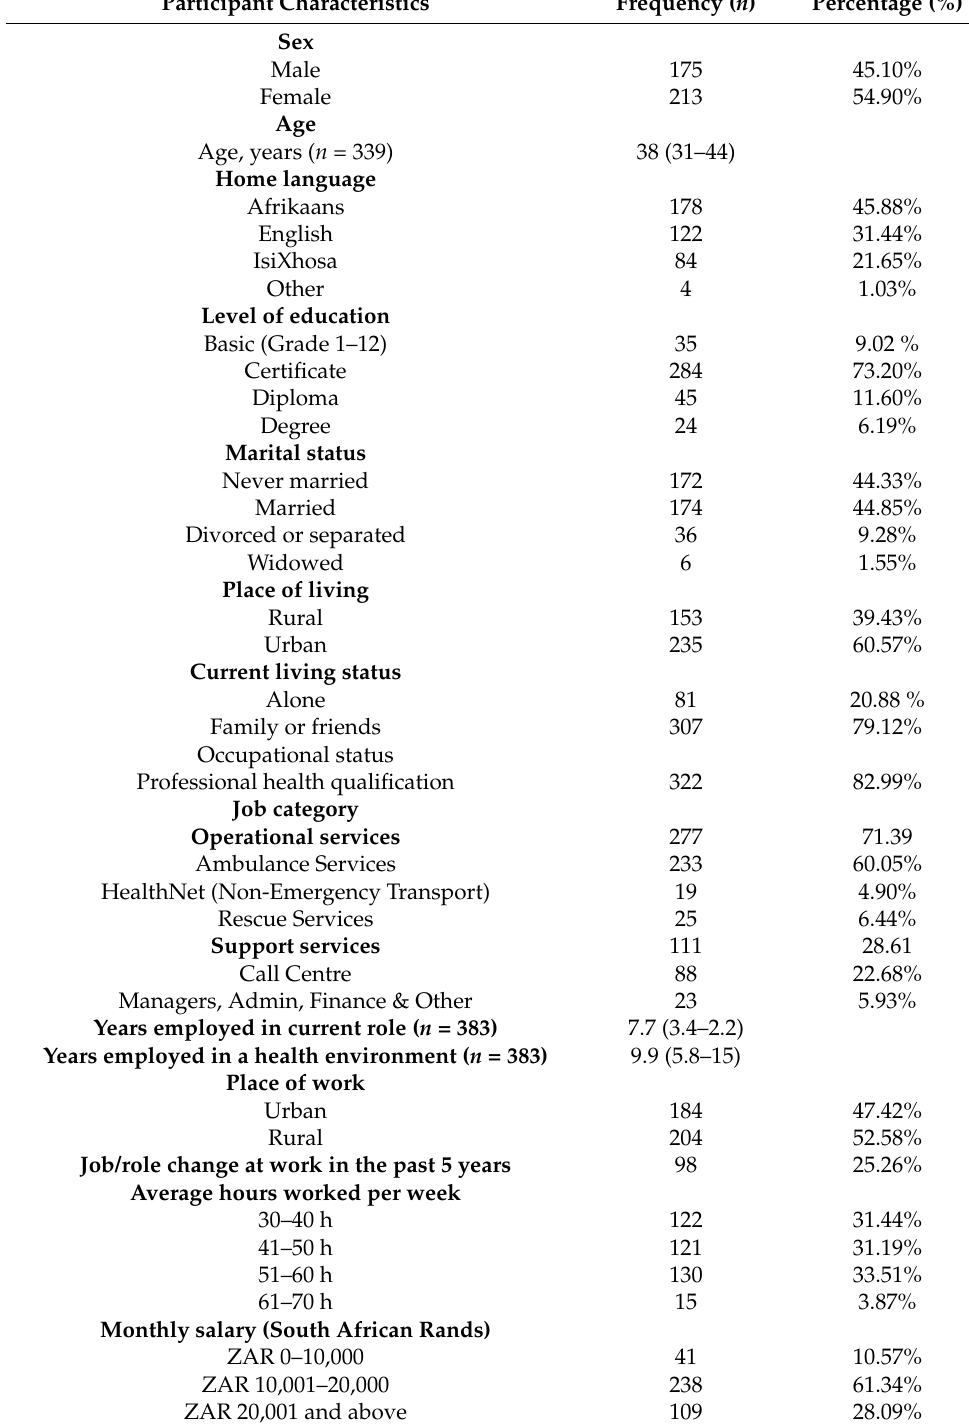
Table 1. Demographic and occupational qualities of participants ( n =